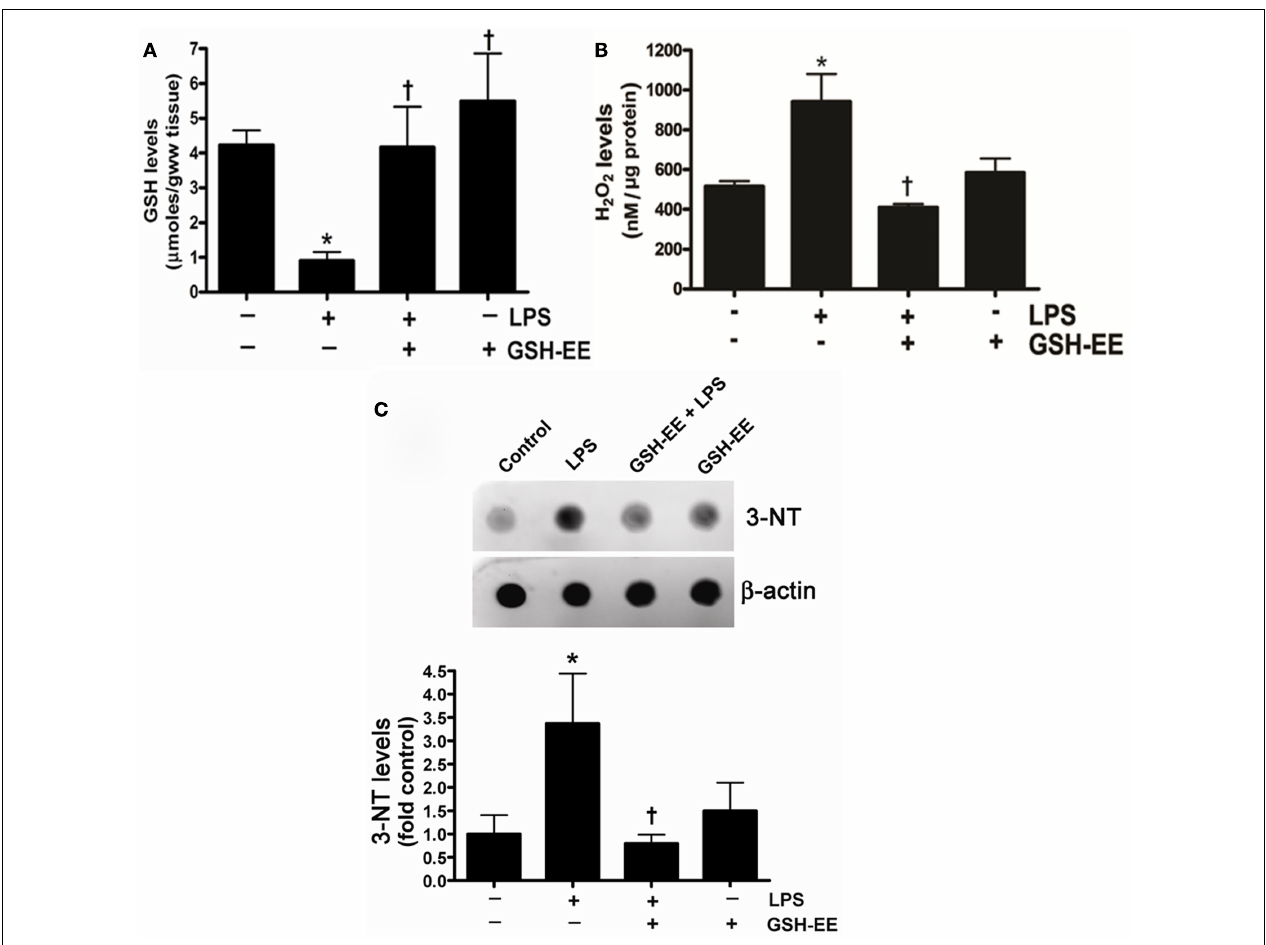
increase in H 2 O 2 levels in LPS-treated mice lungs as compared to controls (B) .Total nitrated protein levels were measured by dot blot analysis (C) . LPS caused significant increases in the formation of H 2 O 2 and nitrated proteins, whereas GSH-EE pre-treatment prevented the LPS-induced increase in these oxidative and nitrosative stress parameters.Values are mean ± SEM; n = 6/group. * P < 0.05 vs. vehicle; † P < 0.05 vs. LPS alone.